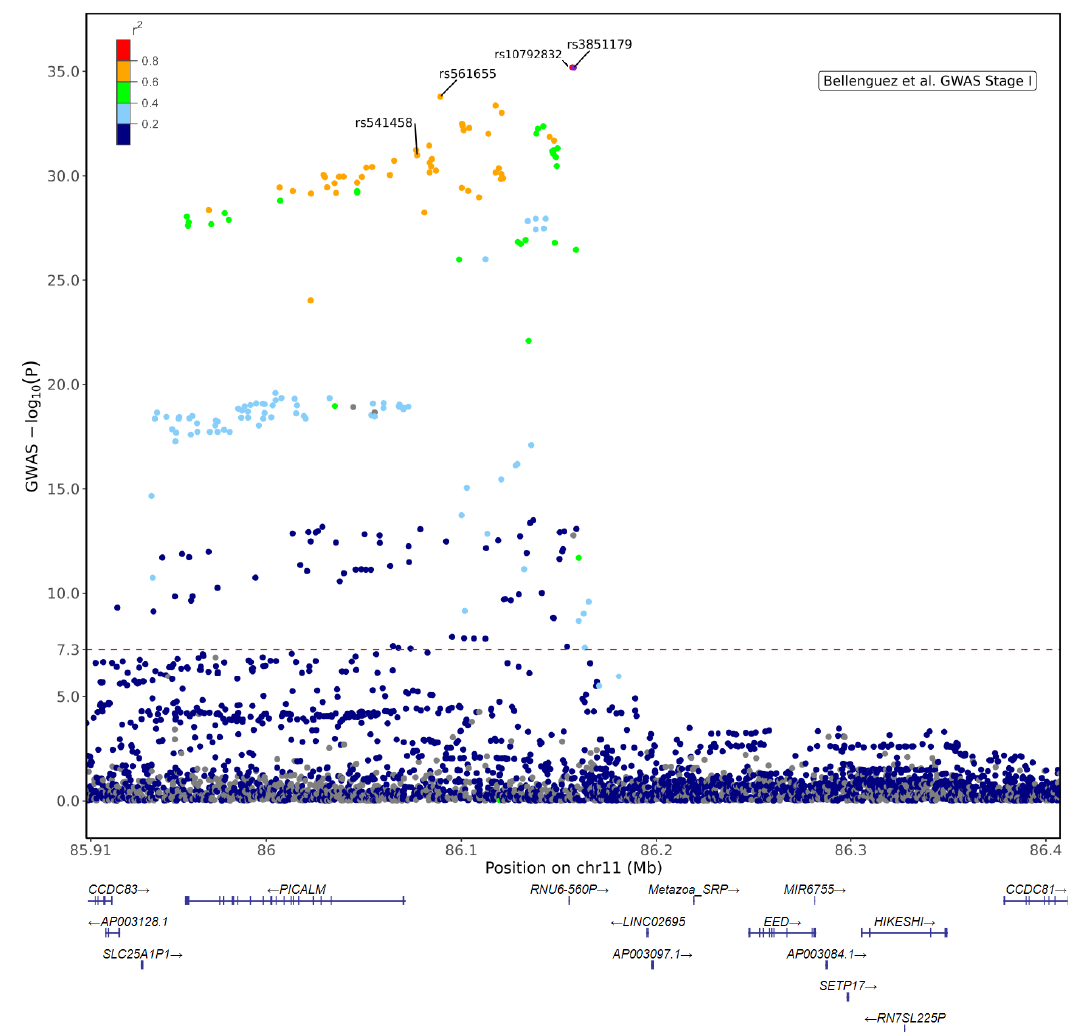
Figure 5. Regional plot for PICALM locus based on Stage I results from [17] (Accession No GCST90027158, https://www.ebi.ac.uk/gwas/Study (accessed on 1 July 2022)). The plot shows the lead variant in Stage I + II meta-analysis, rs3851179 and +/ − 250 kb extended coordinates for n = 3988 variants in chr11:85,907,598–86,407,598 (GRCh38). LD reference data derived from 1000 Genomes Project phased biallelic SNV and INDEL autosomal genetic variants called de novo GRCh38 (for selected n = 404 unrelated Non-Finnish European (NFE) sample) [85]. The lead variant rs3851179 is located in the intergenic region between PICALM and EED in which there are other non-coding genes ( RNU6-560P , LINC02695 and Metazoa SRP ) and a contigs ( AP003097 ). rs10792832 (red) is in almost full LD with rs3851179. Other genome-wide significant SNPs, such as rs561655 [82,86]